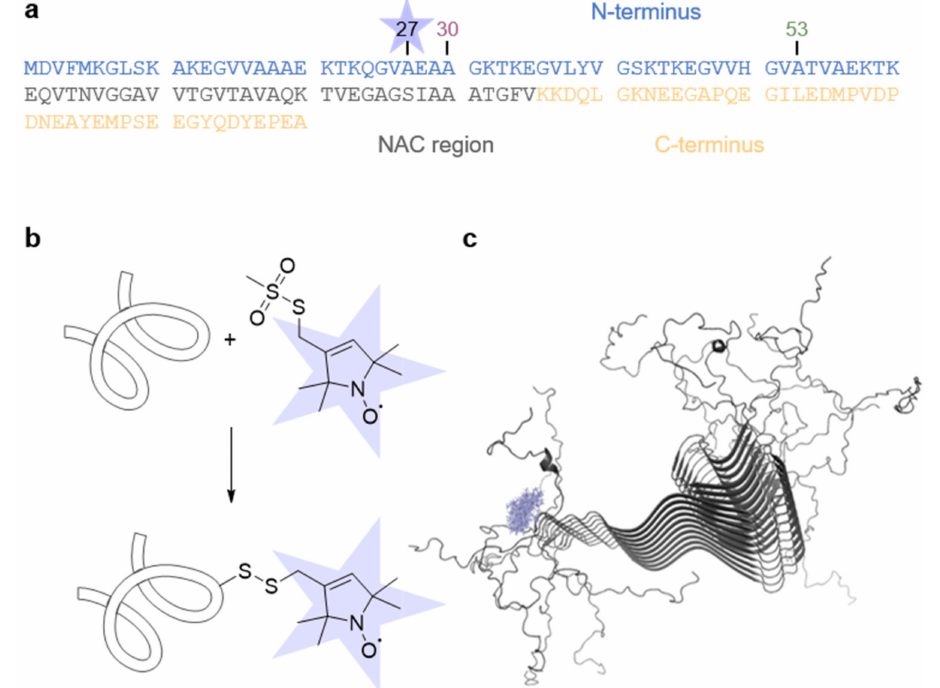
Figure 1. Spin labeling of aS. ( a ) aS primary sequence. The different regions of aS are highlighted. The position of the spin label (blue star) and the disease point mutations A30P and A53T are indicated. ( b ) Labeling scheme of aS with MTSSL spin-label. ( c ) Solid-state NMR fibril structure (PDB ID 2N0A [45]) and MTSSL rotamers (blue) at position